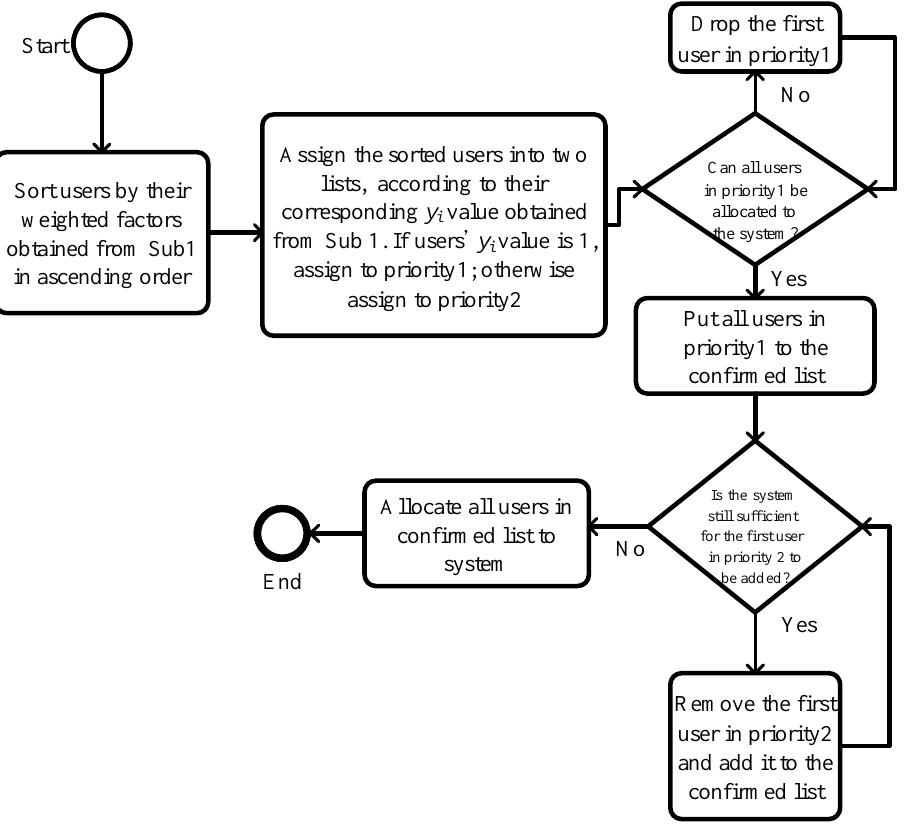
Figure 5. Flowchart of the drop-and-add